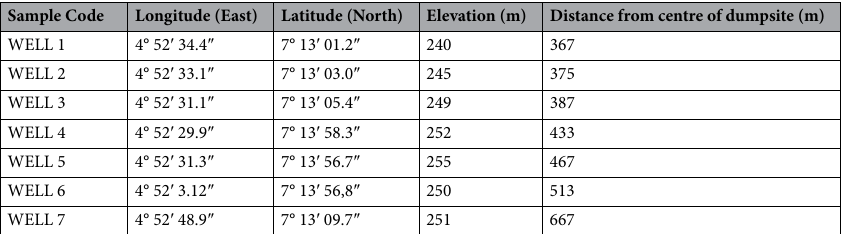
Table 1. General information on water sample